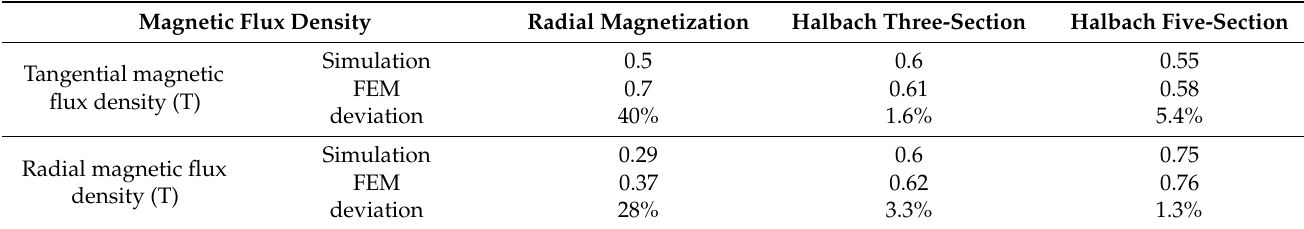
Figure 6. The magnetic flux density of air gap centerline: ( a ) Tangential magnetic flux density; ( b ) Radial magnetic flux density. Table 2. Results of simulation data and FEM data.